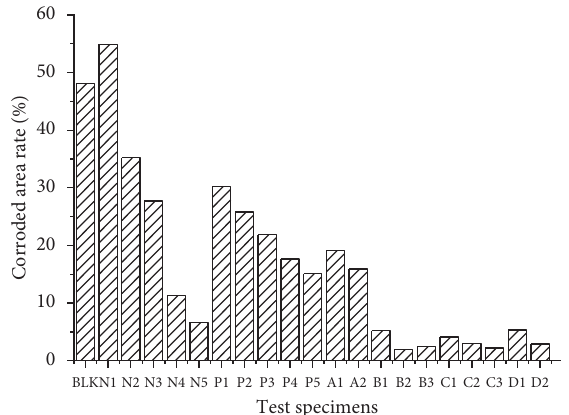
Figure 4: Corroded area rate of reinforcement.